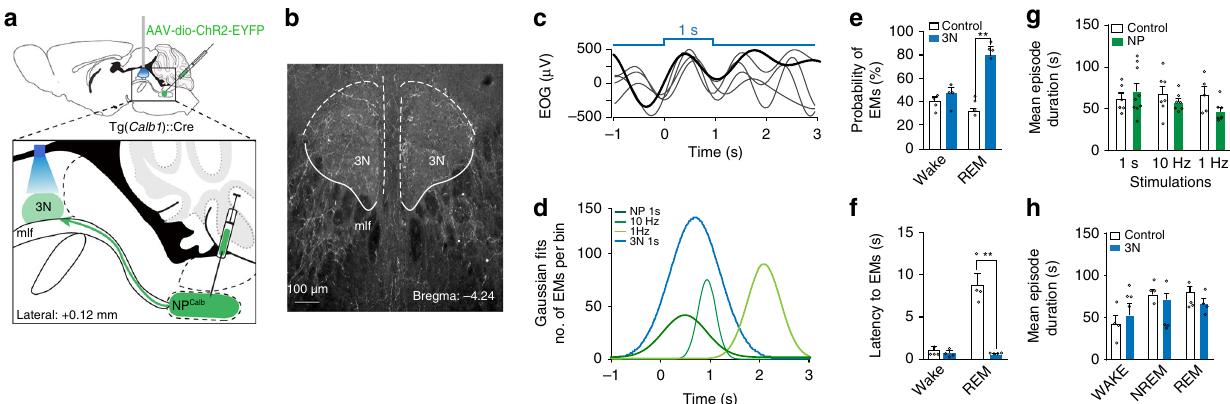
Fig. 4 Optogenetic activation of NP Calb terminals in the oculomotor nucleus. a Schematic representation of the experimental set up used to activate the axon terminals of NP Calb neurons in the oculomotor nucleus (3N). The boxed area represents a higher magni fi cation view of the injection of